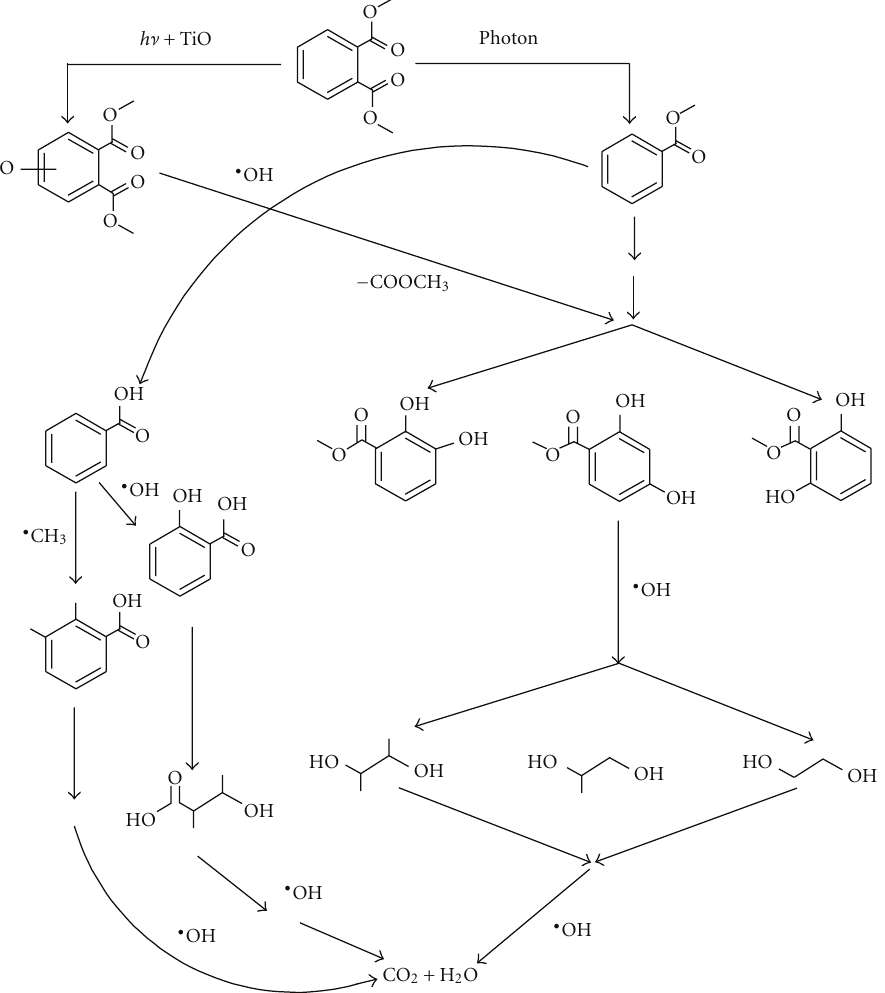
Figure 3: Photocatalytic degradation scheme for DMP